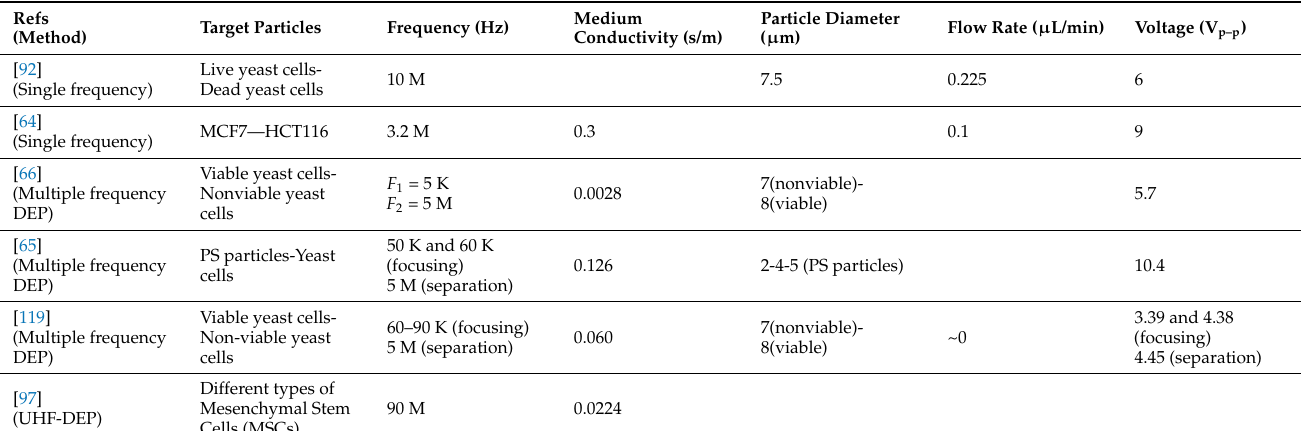
Table 2. Crossover frequency-based methods’ reported parameters.